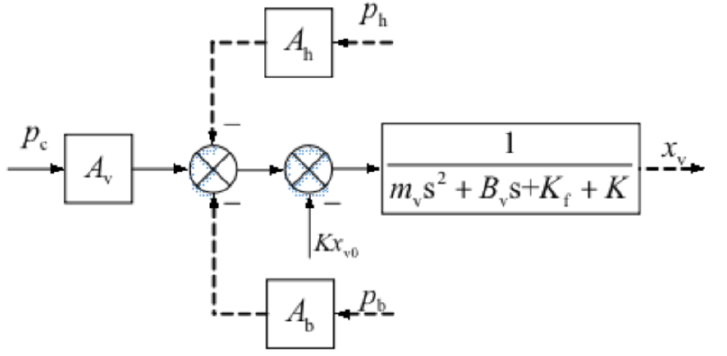
Figure 21. Control block diagram from buildup pressure to power stage spool displacement.